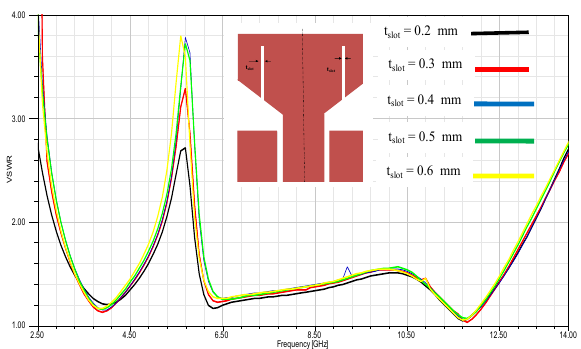
Figure 10: Effect of varying the width of the slots t slot .